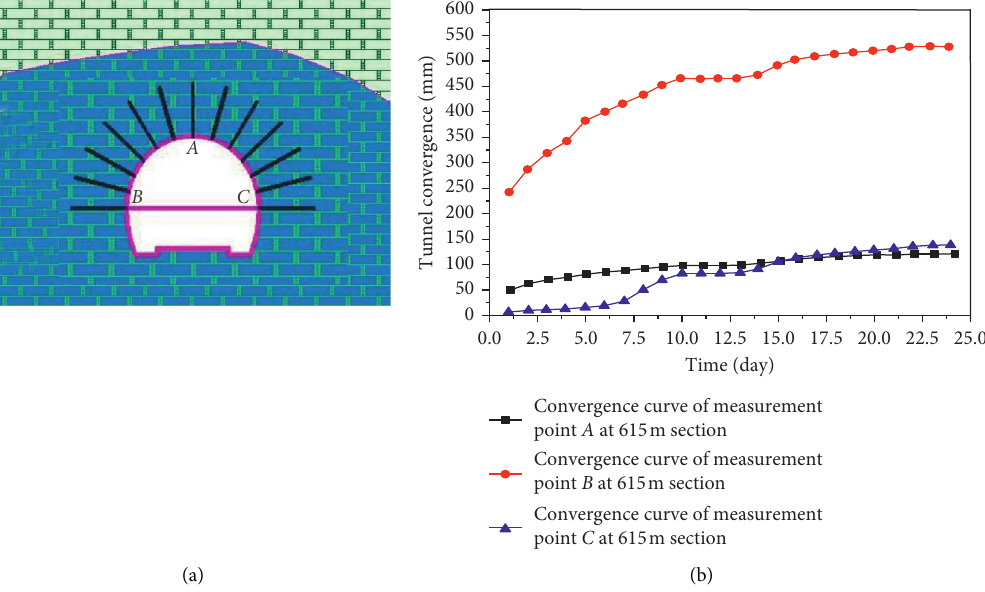
Figure 5: (a) Distribution of tunnel-displacement monitoring points and (b) tunnel-displacement monitoring